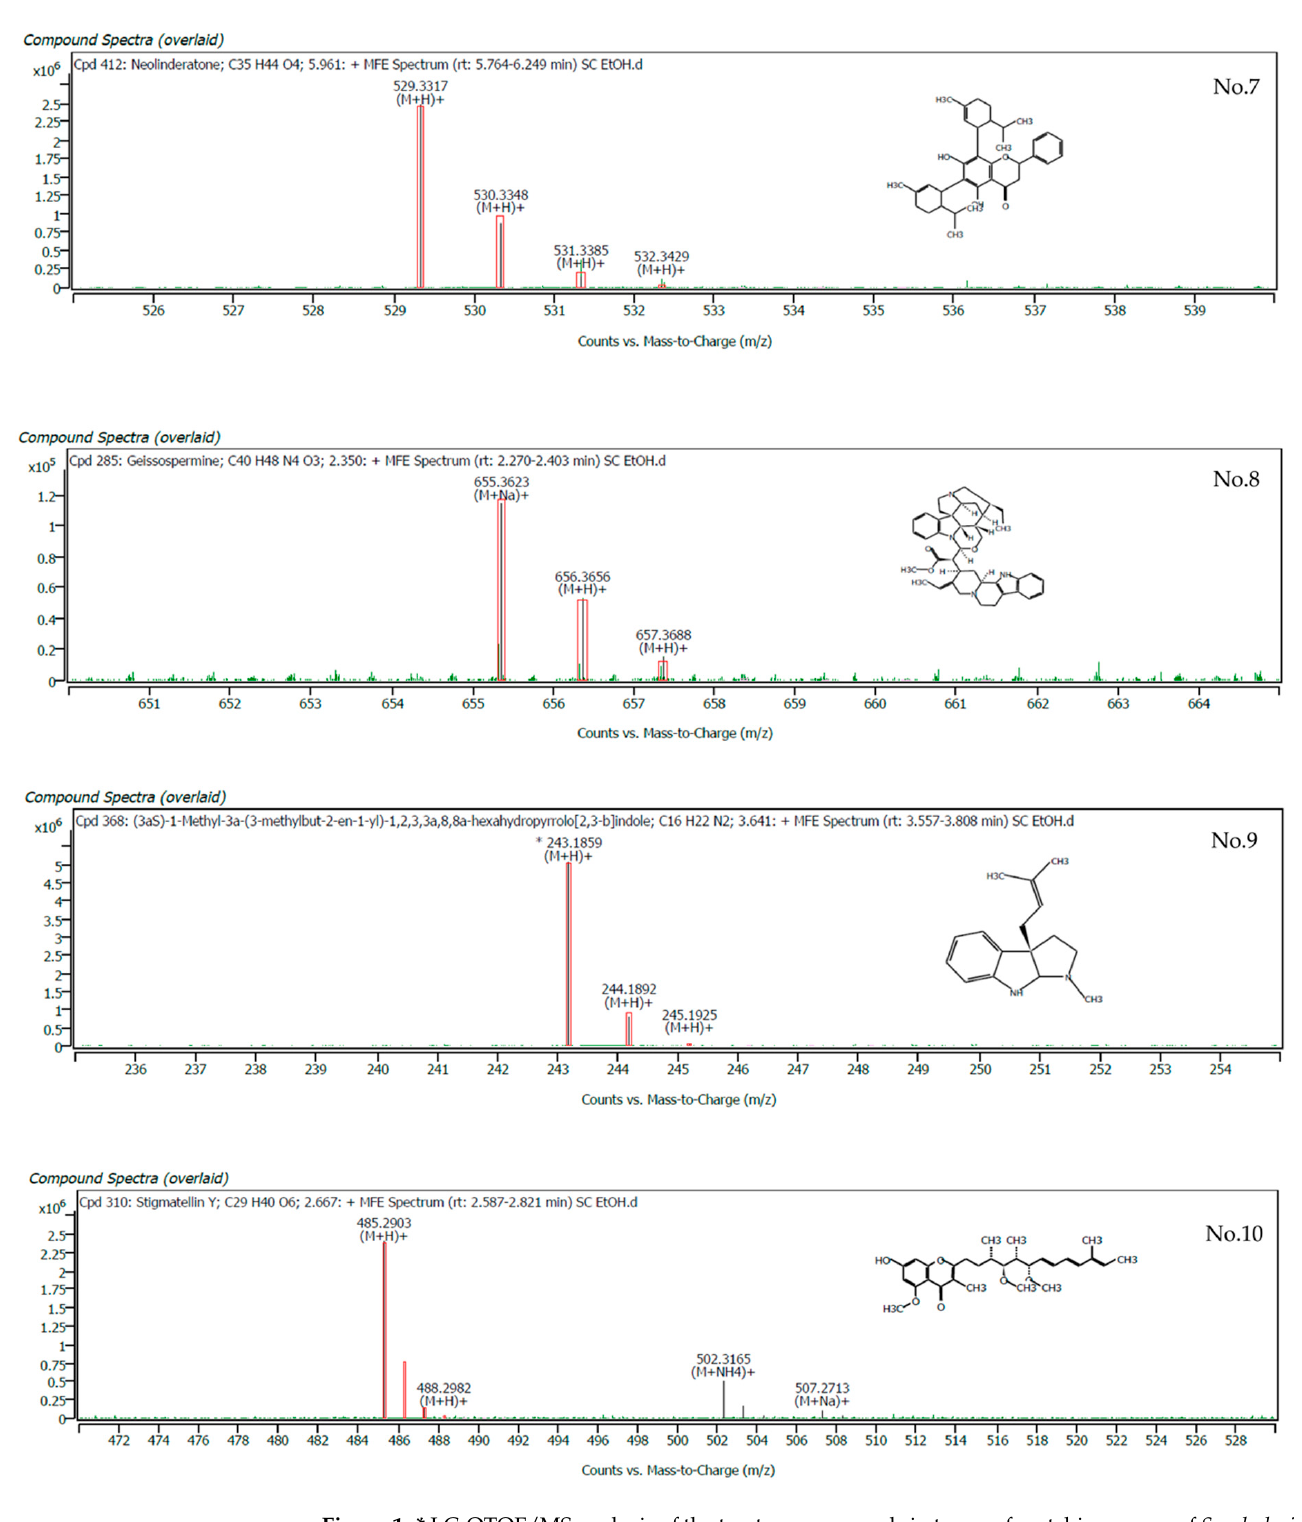
Figure 1. * LC-QTOF/MS analysis of the top ten compounds in terms of matching scores of S. cobularia ethanolic crude extract: ( A ) LC-OTOF-MS chromatogram; ( No. 1 ) mass spectrum of longistylin A; ( No. 2 ) (–)–neolinderatin; ( No. 3 ) 2 ′ ,4 ′ – dihydroxy – 7 – methoxy-8-prenylflavan; ( No. 4 ) ent – 8 – deoxy-J2–IsoP; ( No. 5 ) butoctamide hydrogen succinate; ( No. 6 ) 9Z,12E,15E-octadecatrienoic acid; ( No. 7 ) neolinderatone; ( No. 8 ) geissospermine; ( No. 9 ) (3aS)–1–methyl3a–(3–methylbut–2–en–1–yl)– 1,2,3a,8,8ahexahydropyrrolo [2,3–b] indole; and ( No. 10 ) stigmatellin